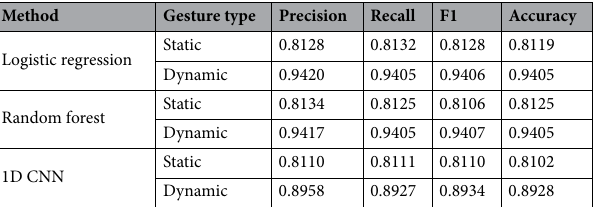
Table 1. Overall evaluation of different classical machine learning and deep learning methods.